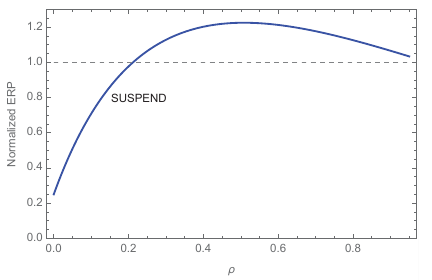
Figure 3: Normalized ERP metric with ideally low setup delay ( E[ T setup ] = E[ S ] ).